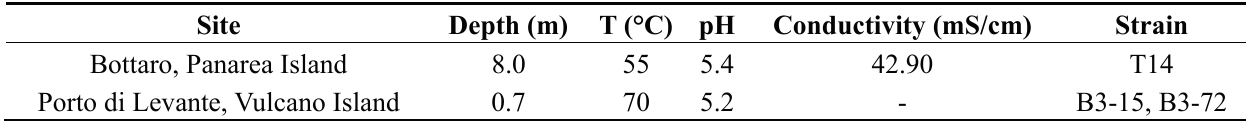
Table 1. Physical and chemical characteristics of thermal fluids emitted from the shallow hydrothermal vents off Eolian Islands (Italy) and related